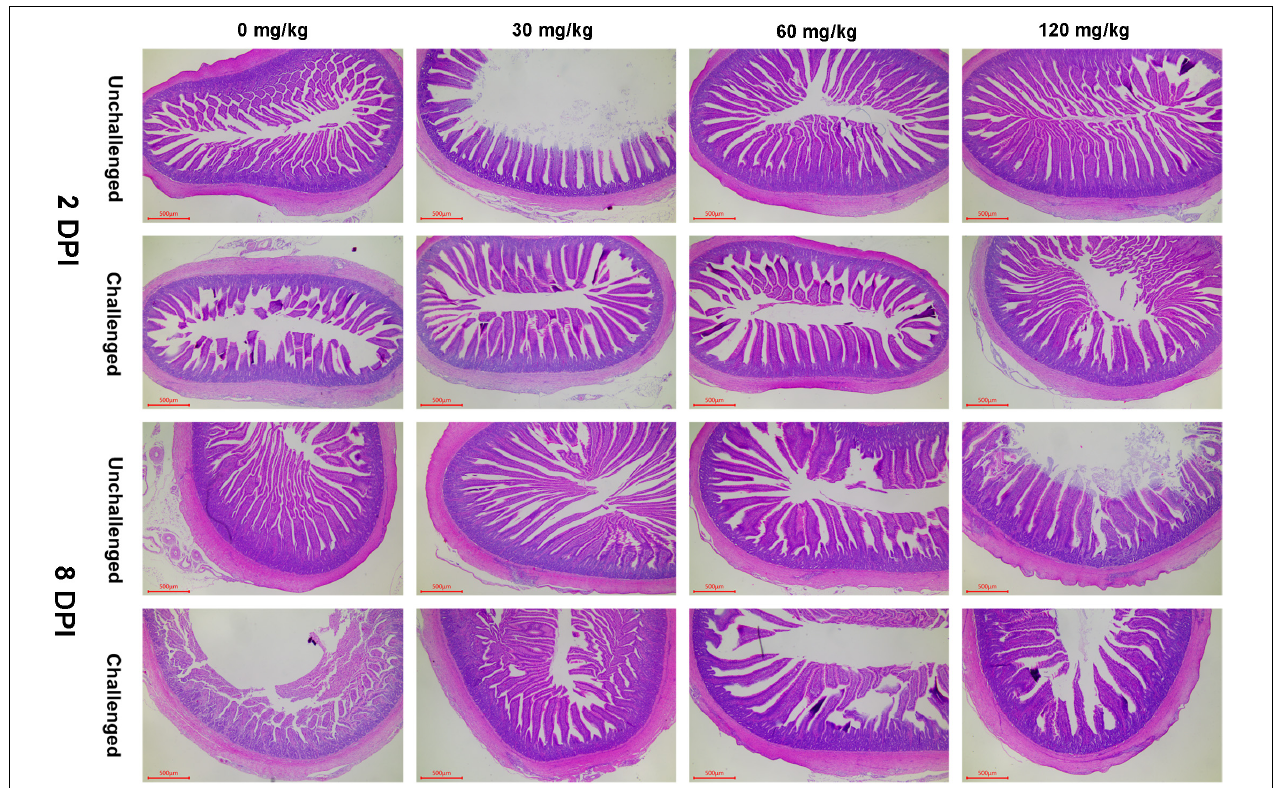
FIGURE 4 | Effect of dietary Zn–Met levels on the jejunum morphology of meat duck challenged with APEC (HE stain). Results are expressed as mean ±